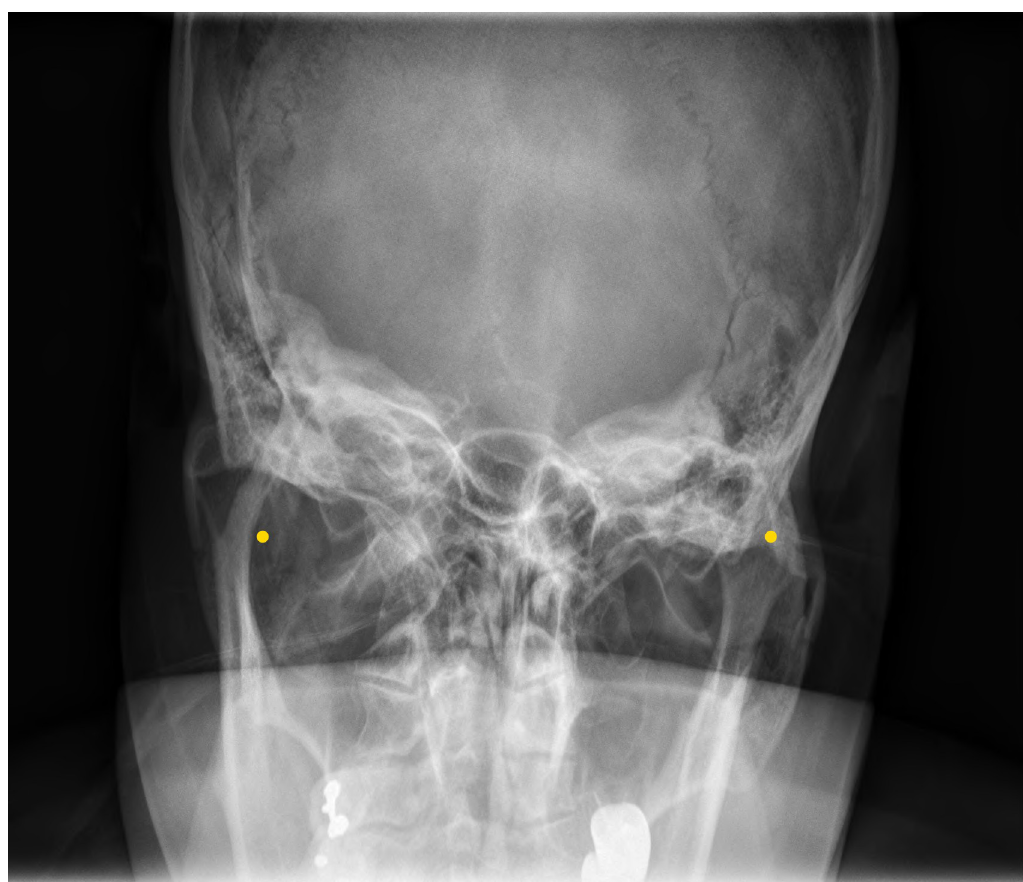
Fig 2. Location of center points for right and left cropping in AP view. The yellow dots represent the center points of cropping the right/left